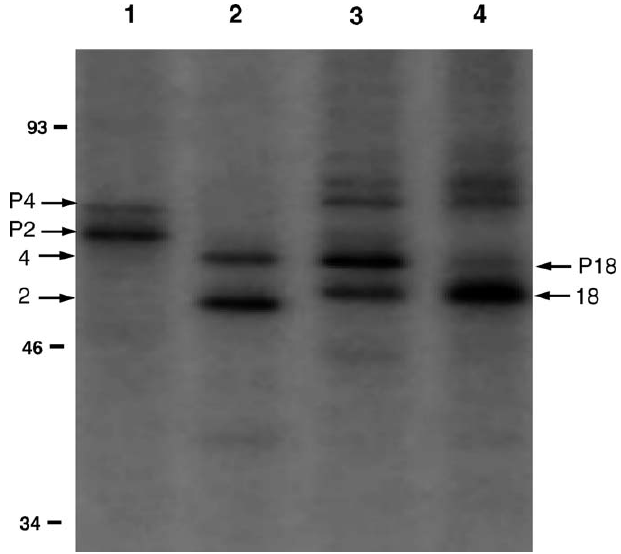
Figure 5. Pulse-Chase Analysis of ROP18 Biosynthesis HFFs were infected with the ROP18-Ty–transfected tachyzoites for 24 h, then labelled for 20 min with [ 35 S] methionine/cysteine and either harvested (lanes 1 and 3) or chased for 1 h (lanes 2 and 4). Then, the NP40 lysate was immunoprecipitated with mAb anti–ROP2–4 (T 3 4A 7 , lanes 1 and 2) or mAb anti-Ty (lanes 3 and 4). Lane 3 shows a major band at 60 kDa (P18), whereas a 56-kDa major protein (18) is found in lane 4. The control with mAb T 3 4A 7 that immunoprecipitates ROP2 (2) and ROP4 (4) shows parallel processing of both proteins from higher molecular mass precursors (P4 and P2). doi:10.1371/journal.ppat.0030014.g005 PLoS Pathogens |